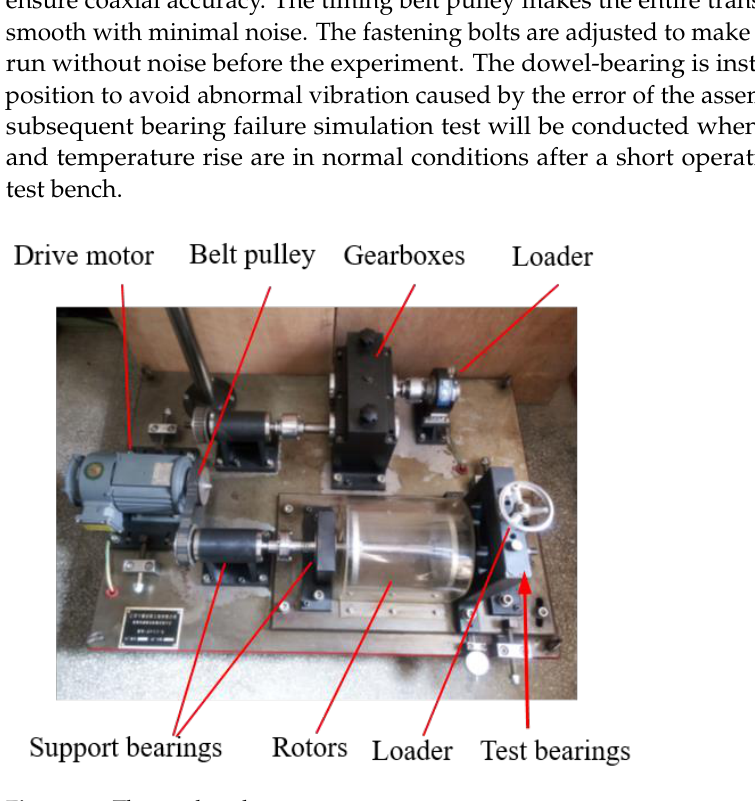
Figure 10. The test